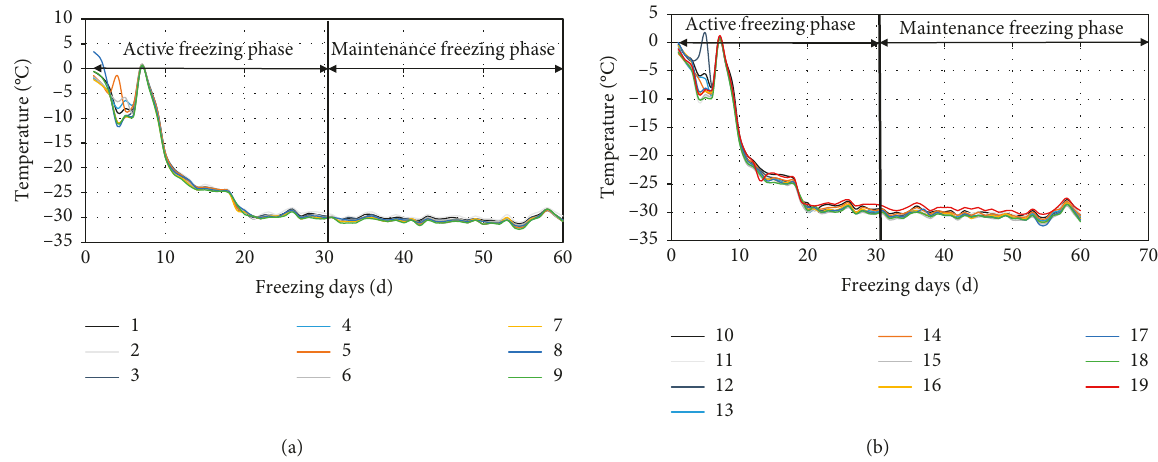
Figure 7: Curves of the temperature change in 19 branch pipes of the saline loop. (a) Branch nos. 1–9; (b) Branch nos. 10–19.